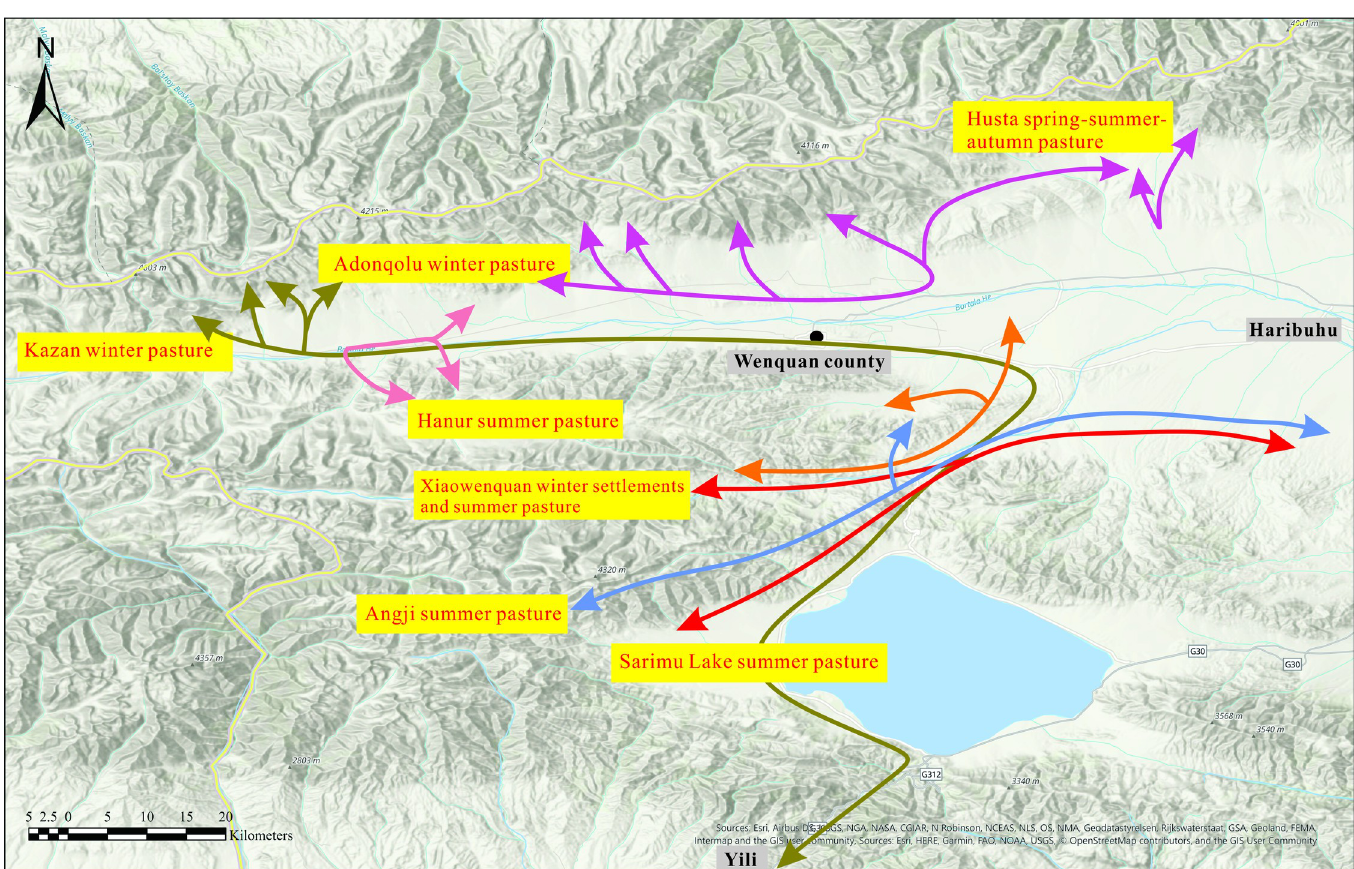
Fig 3. Transhumant routes among the local herders in Wenquan. Map created using ArcGIS Pro 2.5.0. Single use licence issued to Meng Qi by ESRI Australia Pty Ltd (Environmental Systems Research Institute). We acknowledge the use of Esri base maps as noted in the image.